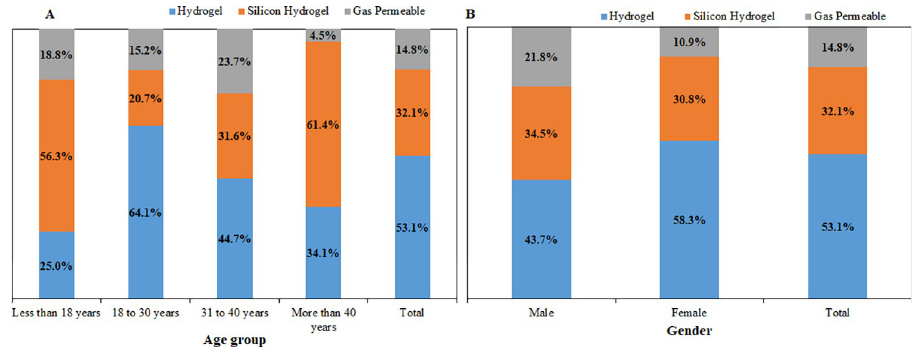
Fig 3. Distribution of contact lens wear regimen/replacement schedule by : (A) age group and (B) , gender of